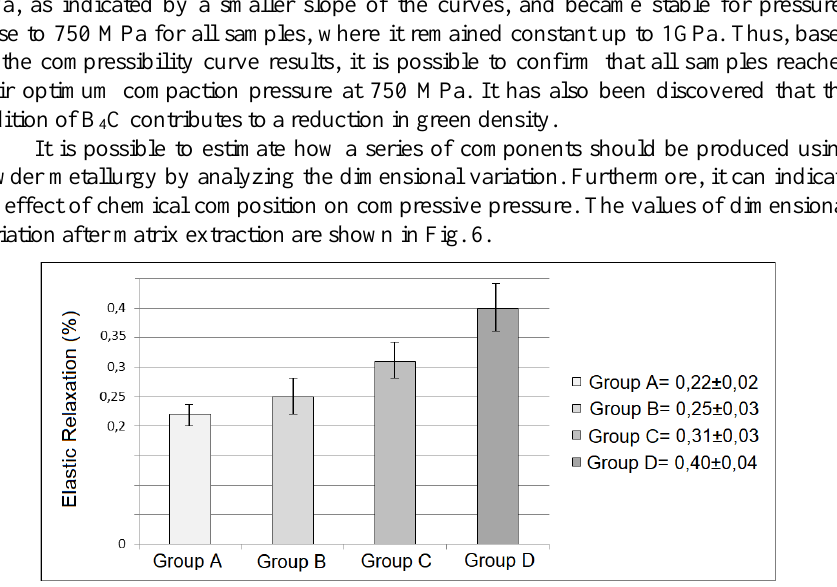
Fig. 6. Dimensional variation of Groups (A, B, C and D) represented by elastic relaxation after extraction of the matrix at a compaction pressure of 750